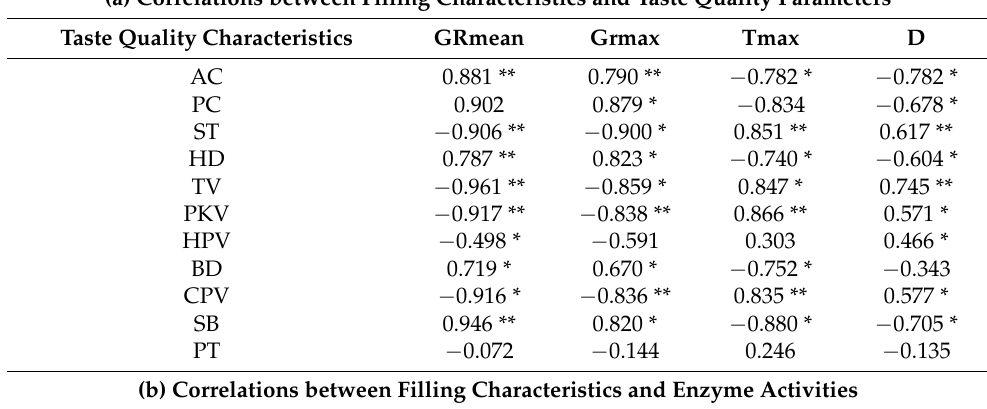
Table 1. Correlation analysis among grain quality, filling characteristics and enzyme activities. (a) Correlations between Filling Characteristics and Taste Quality